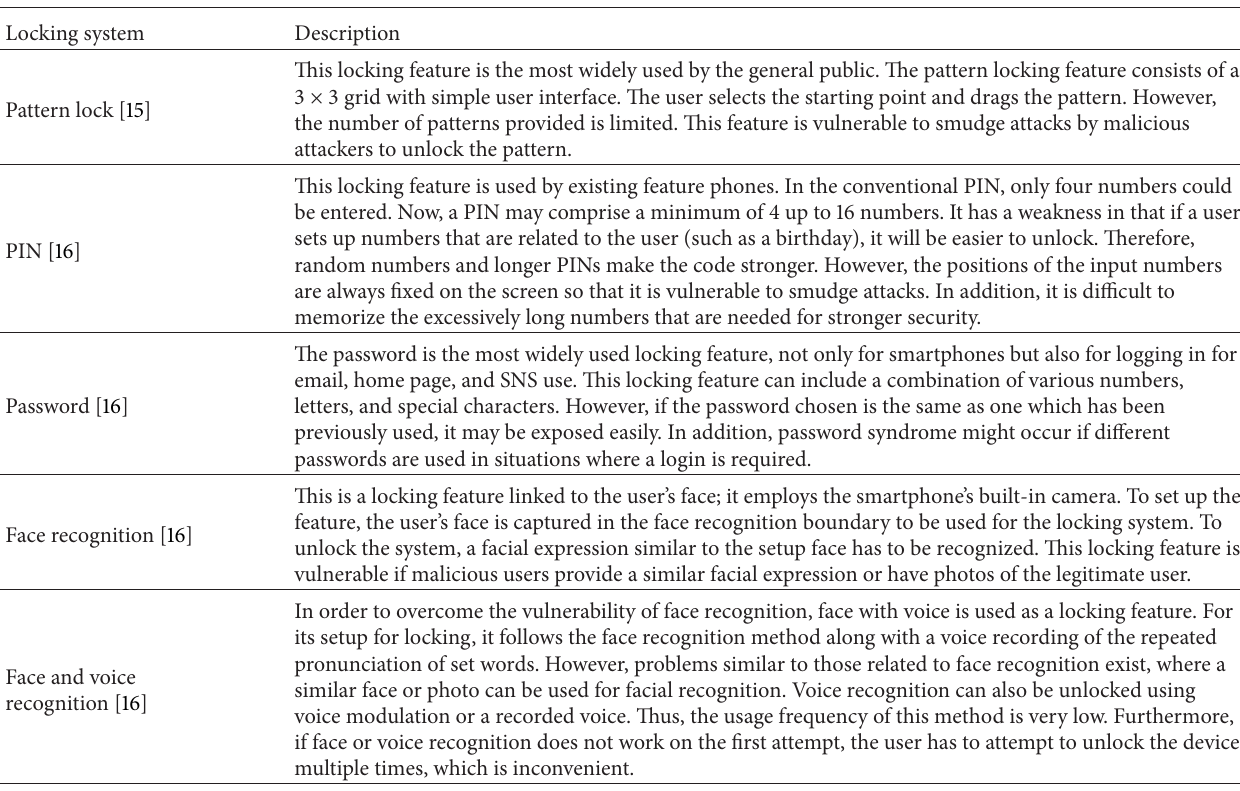
Table 1: Basic types of built-in locking features in multimedia